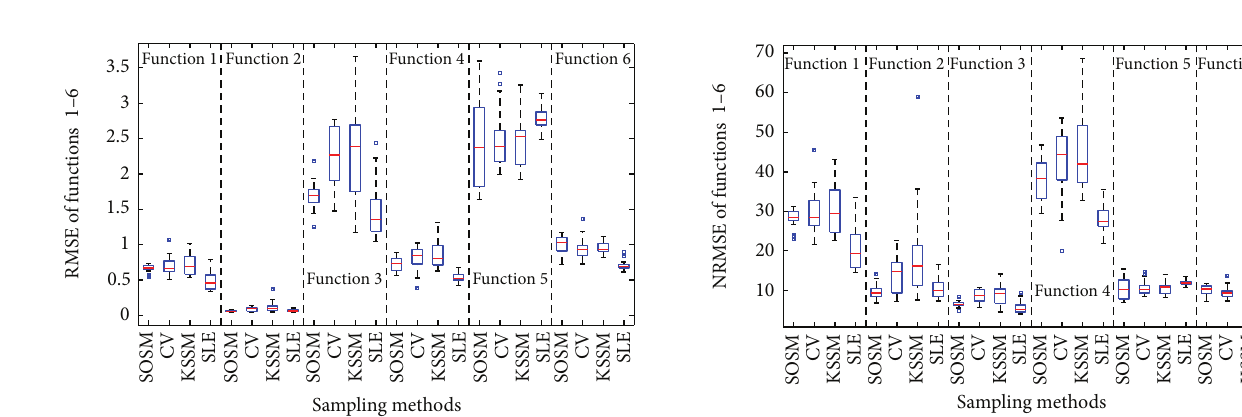
Figure 17: Assessment of metamodels: RMSE between SOSM and previous sequential sampling methods.